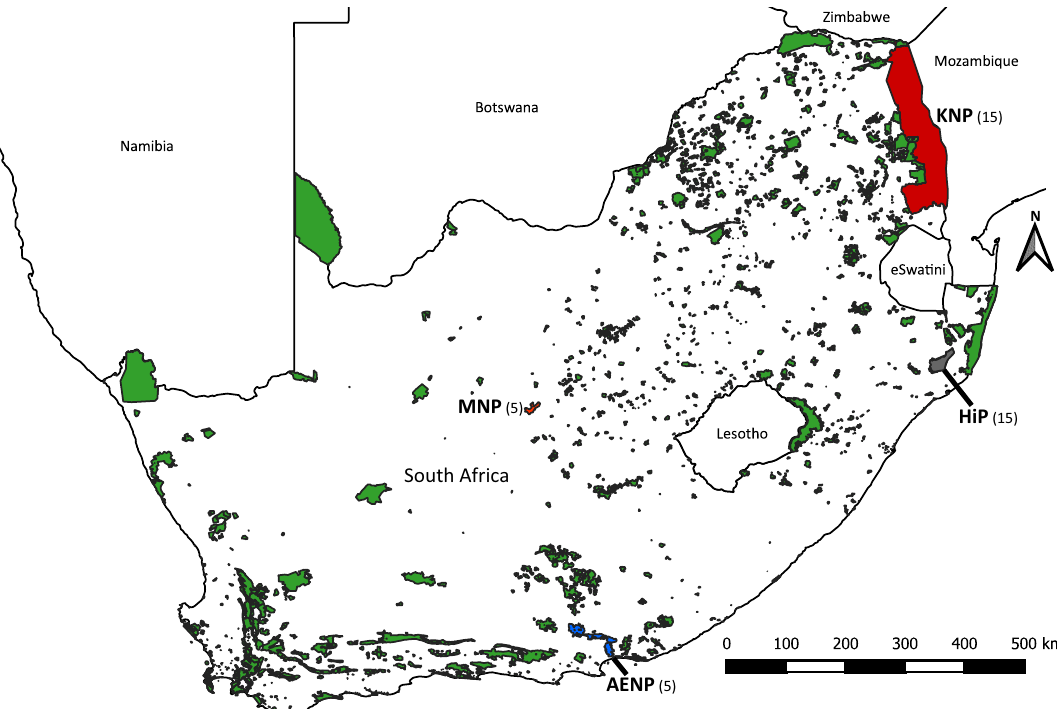
Figure 1. Sampling localities of buffalo included in this study. Sampling localities are shown in colours other than green. Sample sizes are indicated in parentheses. Green polygons show all other terrestrial protected areas in South Africa. The protected area shapefile was downloaded from https ://egis.envir onmen t.gov.za/prote cted_and_conse rvati on_areas _datab ase, accessed on 10/08/2020. The map was created in QGIS v3.4 29 (https :// www.qgis.org/en/site/), with labels and colours for sampling localities added in Inkscape v0.92 30 (https ://www. inksc